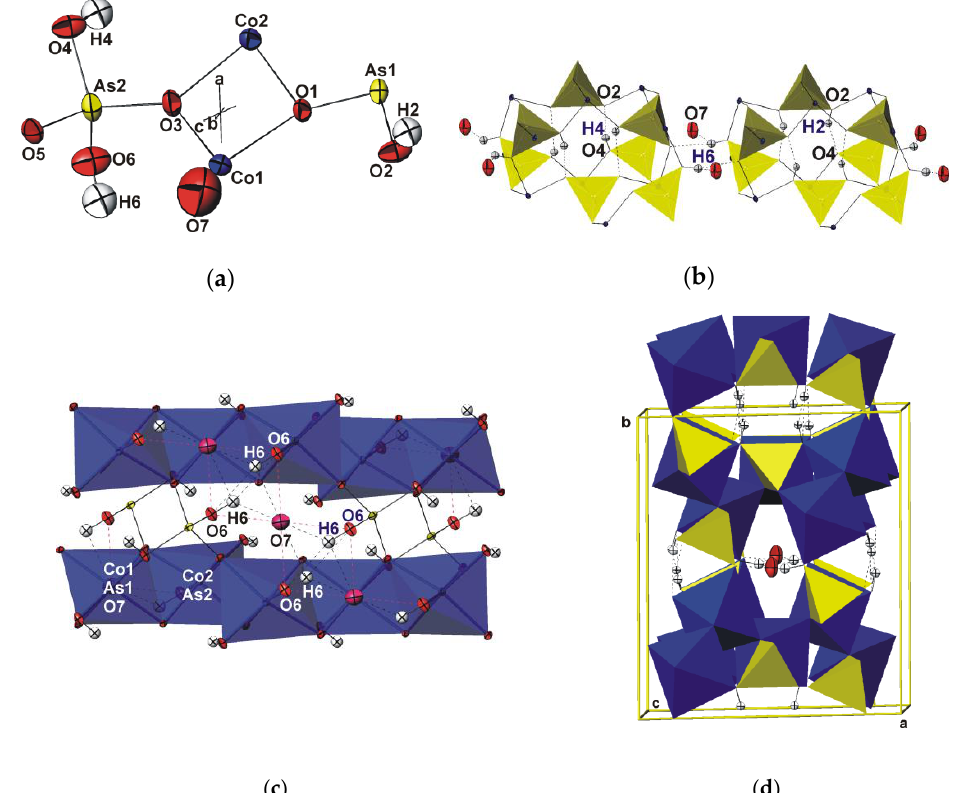
Figure 2. The asymmetric unit with the atom-numbering scheme ( a ); hydrogen bonds within the channel 1 and bifurcated hydrogen bonds O6—H6 · · · O6 ix and O6—H6 · · · O7 ix (symmetry code: (ix) − x + 1, − y + 1, − z + 1) in channel 2 ( b ); the view along [010] of curved chains composed of edge-shared Co1O 6 and Co2O 6 octahedra with water oxygen O7 acting as single hydrogen bond acceptor of H6 (black dotted lines) and as a possible double bond donor toward four symmetry-equivalents of adjacent O6 (red dotted lines) ( c ); the projection of the structure nearly along [001] direction ( d ). Displacement ellipsoids are plotted at the 90% probability level. The octahedral chains (blue) with arsenate tetrahedra (greenish-yellow), H atoms of hydroxyl groups (light gray circles) in both channels and O7 atoms (red ellipsoids) of water molecule in channel 2. In both channels, the half of H and O7 atoms is arbitrary omitted in order to illustrate their half-occupied positions.